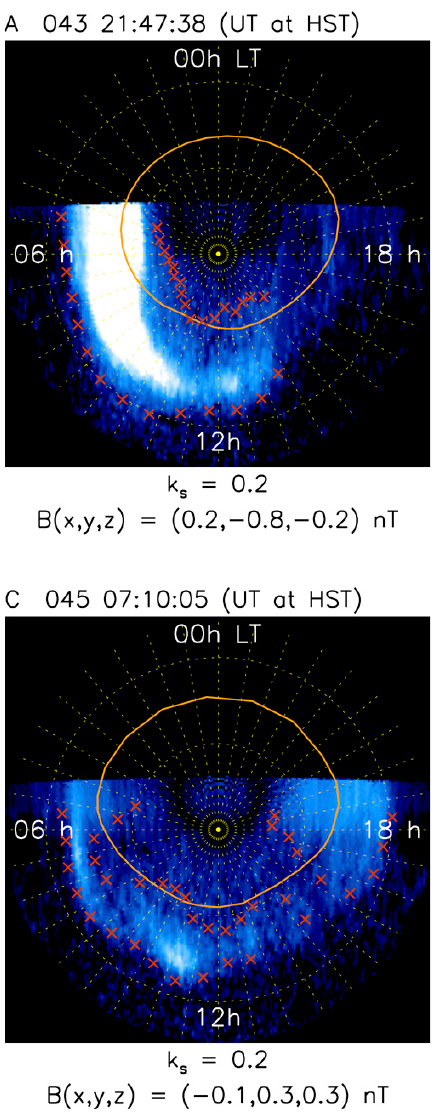
Fig. 2. Plots showing two HST UV images of Saturn’s southern auroras, projected onto a spheroidal surface 1100km above the at- mospheric 1bar level, with noon at the bottom and dawn to the left. The view is thus “through” the planet from the north. Dotted yellow lines show a latitude-longitude grid at 10 ◦ intervals in each case. Only the dayside portion of the oval was well-observed due to the pre-equinoctial conditions prevailing, such that the images are trun- cated somewhat beyond the dawn-dusk meridian. Image identifiers are given at the top of each panel together with the start time of the ∼ 20min combined exposure time. The locations of the pole- ward and equatorward boundaries of the emission in each image are shown by red crosses, determined at 10 ◦ intervals of longitude from a 5kR limiting emission intensity. The superposed solid or- ange lines show the open field regions for k S = 0 . 2 in each case, calculated using the paraboloid magnetic field model and the corre- sponding averaged IMF vector determined from Cassini data, indi- cated in rounded form at the bottom of each